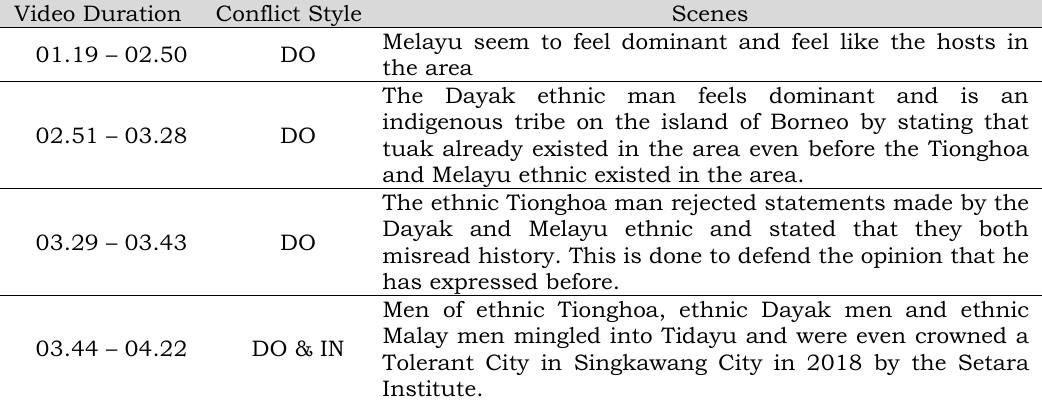
Table 6. Meaning of conflict style in video as